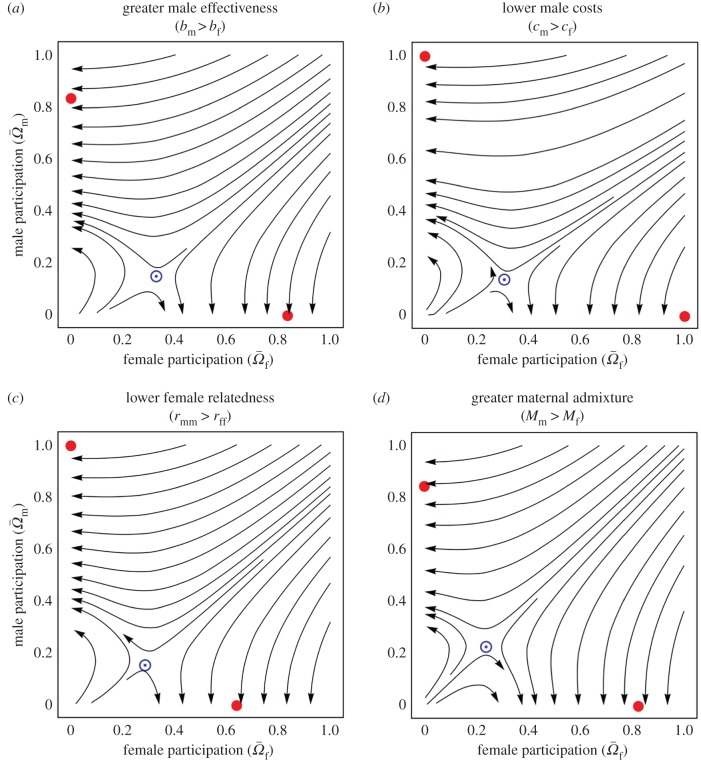
Evolution of male and female participation in the context of other sex differences in the ecology of war. Streamline plots showing the evolution of male and female participation in warfare  when personal costs are decelerating and: effectiveness is greater for men than for women (bm > bf; a); men suffer lower personal costs than women (cm < cf; b); women are less related to their same-sex group mates than men (rmm > rff; c) as a result of female-biased dispersal; maternal admixture is greater than paternal admixture (Mm < Mf; d). Filled red circles represent stable equilibria and circled blue dots represent unstable equilibria. For the purposes of illustration, we assume a competitiveness functional form , and a symmetrical war outcome function , where  and  are the fighting strengths of the attacker and the defender, respectively (see electronic supplementary material for details). Other parameter values are , , Nf = Nm = 10, ψf = ψm = 1 (except panel a: ψf = 0.7, ψm = 1), χf = χm = 0.12 (except panel b: χf = 0.14, χm = 0.1), mf = mm = 0.2 (except panel c: mf = 0.3, mm = 0.1), sf = sm = 0.15 (except panel d: sf = 0.3, sm = 0). (Online version in colour.)